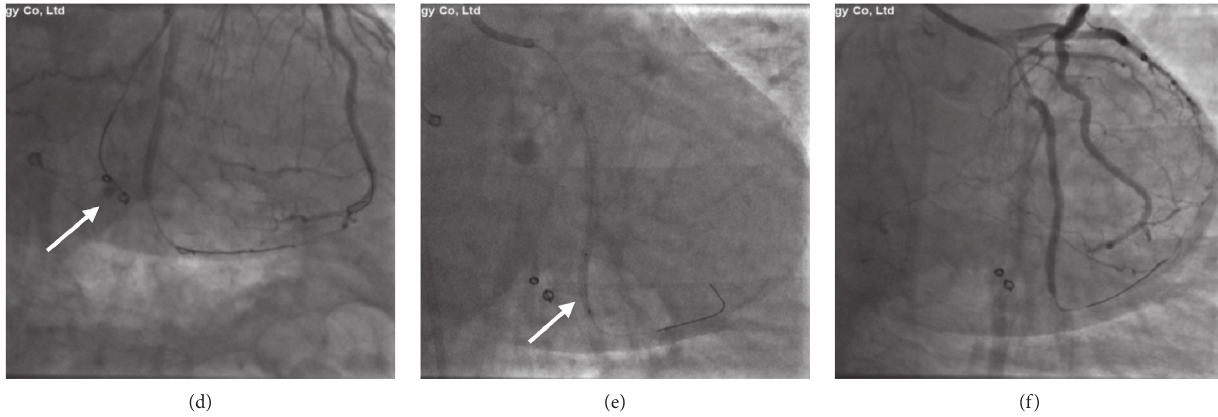
Figure 3: Example of coils and self-made PU-CS implantation to seal a grade II coronary perforation located in the collateral of LCX. (a) CAG reveals LCX-CTO lesion and the collateral vessel of LCX (arrow). (b) CAG shows the coronary perforation in the collateral of LCX caused by guidewire and balloon dilation (arrow). (c) CAG depicts the deployment of two coils (Cook 2.0 × 2.0 mm) (arrow). (d) CAG demonstrates the existing extravasation after coil implantation in the collateral of LCX and stent implantation (Synergy 2.5 × 38 mm & 3.0 × 16 mm) in LCX (arrow). (e) CAG presents the deployment of the self-made PU-CS (2.5 × 18 mm) in the distal segment of LCX to occlude the collateral perforation (arrow). (f) Final angiography after successful implantation of CS. PU-CS � polyurethanecovered stent; Table 3: In-hospital clinical outcomes.